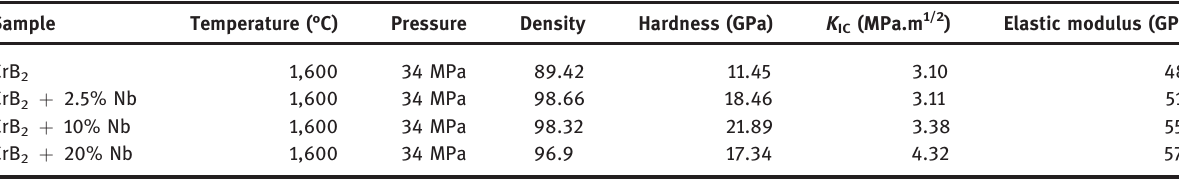
Table 1: Effect of Nb addition on densification and properties of CrB 2 . Sample